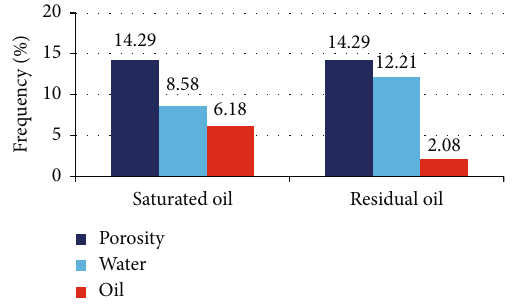
Figure 4: Saturation